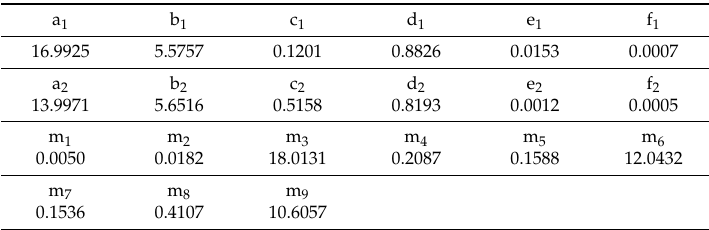
Table 3. Model coefficients in Equations (1) to